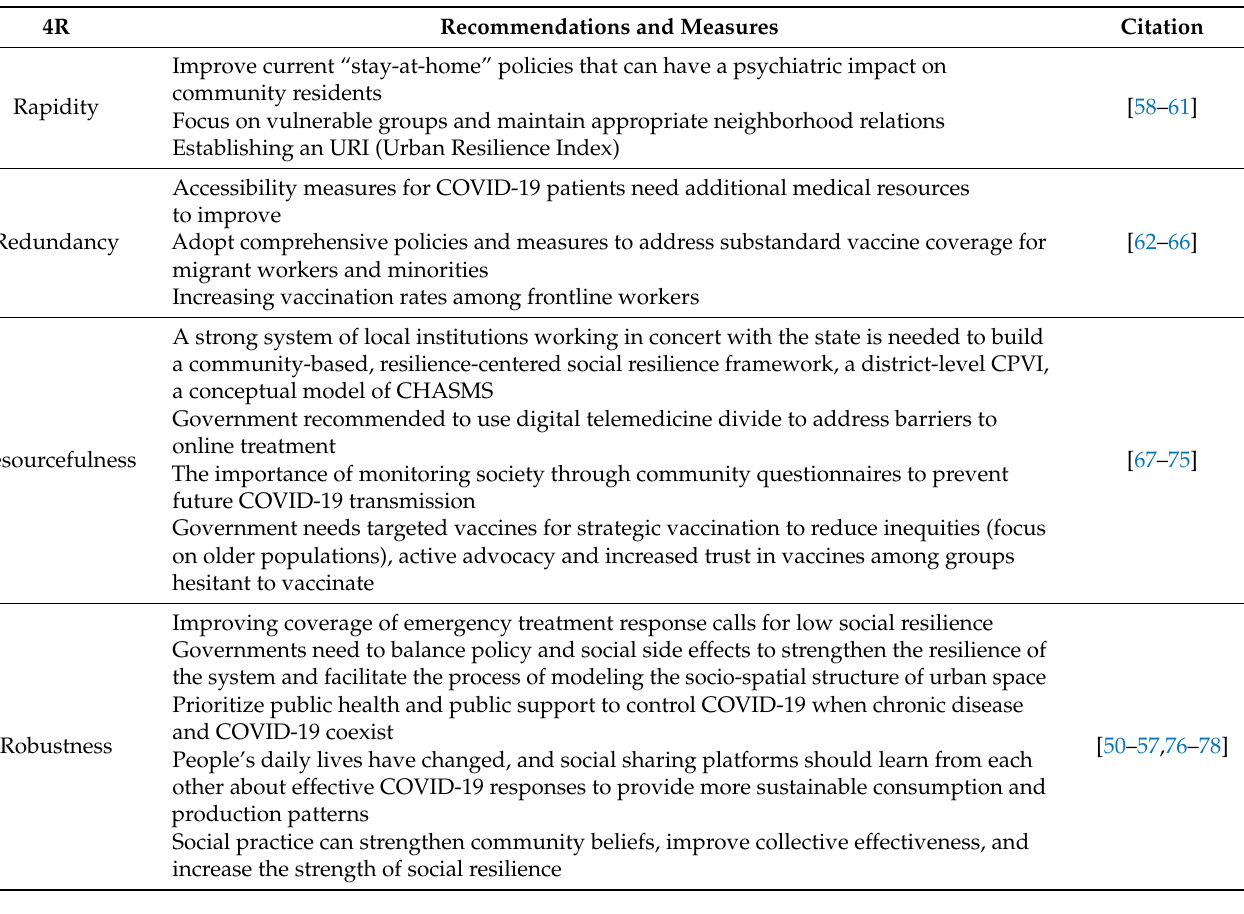
Table 2. The recommendations and measures of social resilience to